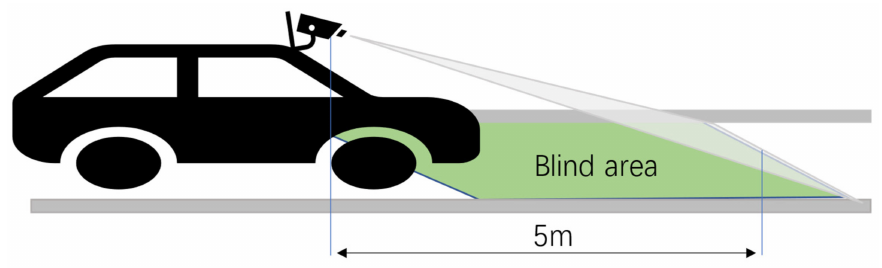
Figure 17. The blind area of the camera.